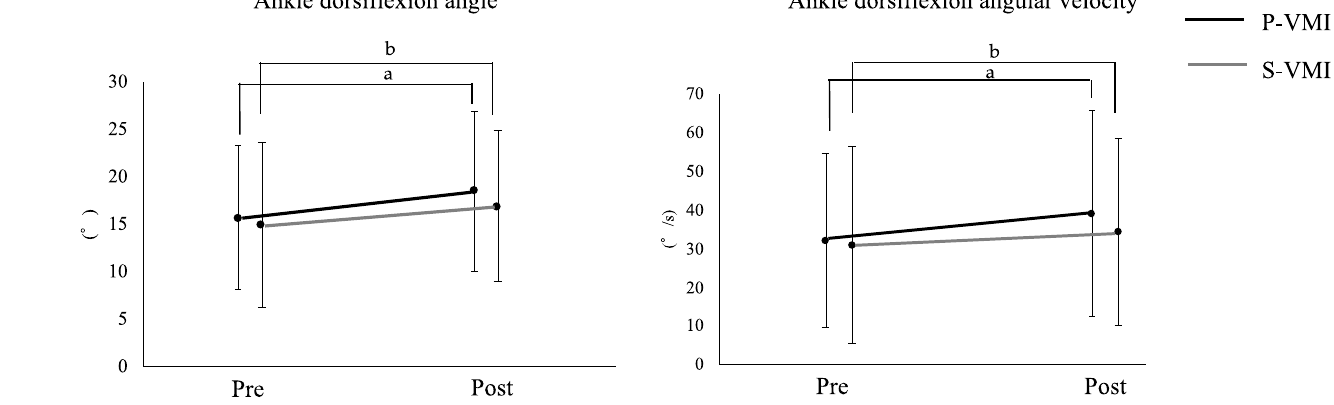
Figure 3. Results of Effect sizes pre and post VMI. a: Effect size of post hoc test is large. b: Effect size of post hoc test is medium. Abbreviations: P-VMI, Power-VMI; S-VMI, Standard-VMI; VMI, visual-motor illusion.